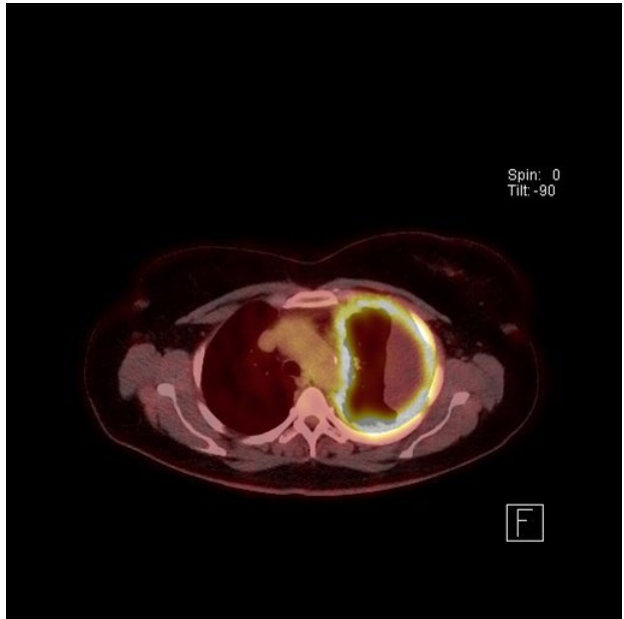
Figure 4. FDG − PET of a 68-year-old female whose husband worked as a carpenter, demonstrating circumferential pleural thickening with increased FDG activity and loculated malignant pleural effusion.